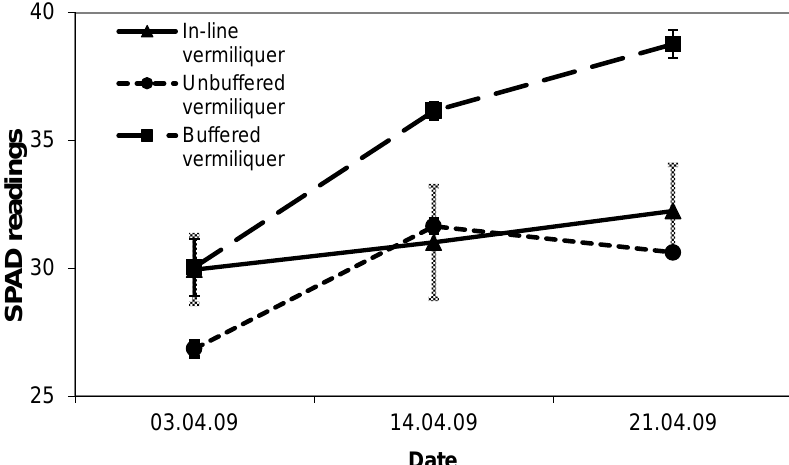
Figure 5. Trend in SPAD readings (arbitrary units) over time in the in-line, the buffered and unbuffered batch vermiliquer treatments in Study V, transplanted 26 March 2009. Vertical bars represent SD of the mean.